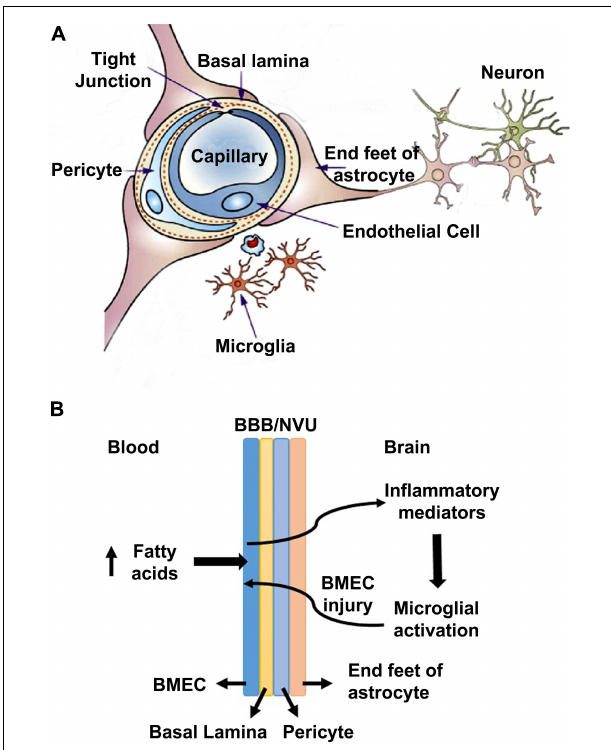
FIGURE 7 | A model for the interactions of obesity with BBB (A) A schematic diagram for the neurovascular unit (NVU) is presented here. NVU comprises of brain microvascular endothelial cells (BMECs), end feet of astrocytes and pericytes. BMECs are glued together by tight-junction (TJ) proteins, which form the blood brain barrier to maintain the homeostasis of the brain. (B) A potential mechanism is presented here, based on the findings of this study. High concentration of saturated fatty acids in blood, as observed in obesity, acts on BMECs and induces the expression of inflammatory mediators, which activate microglia. Activated microglia, in turn acts on BMECs, leading to a vicious